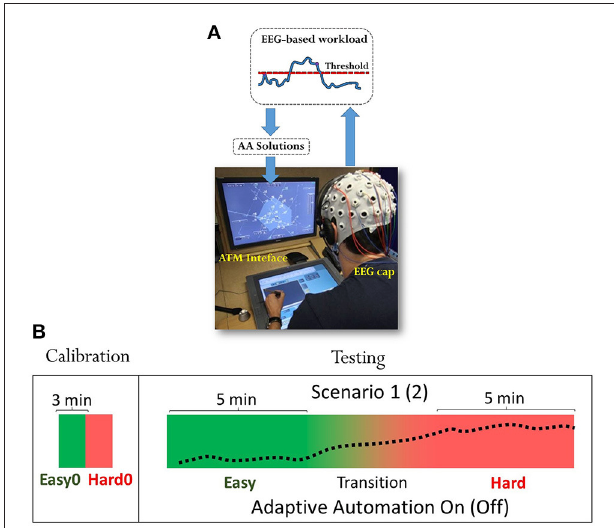
FIGURE 1 | (A) figure shows ATCO students wearing the EEG cap during the experiment and managing the ENAC platform, composed of two screens, a 30 ′′ (RADAR) screen to display radar image and a 21 ′′ screen to interact with the radar image (ATM interface). The mental workload of the user was evaluated online and specific AA solutions changed online the behavior of the RADAR screen depending on the actual mental workload level. (B) ATCO students have been asked to perform two ATM scenarios, one in which adaptive solutions could be triggered by the EEG mental workload index (AA On), and the other one in which adaptive automation has been disabled (AA Off). Presentation of each scenario and condition has been randomized to avoid any habituation and expectation